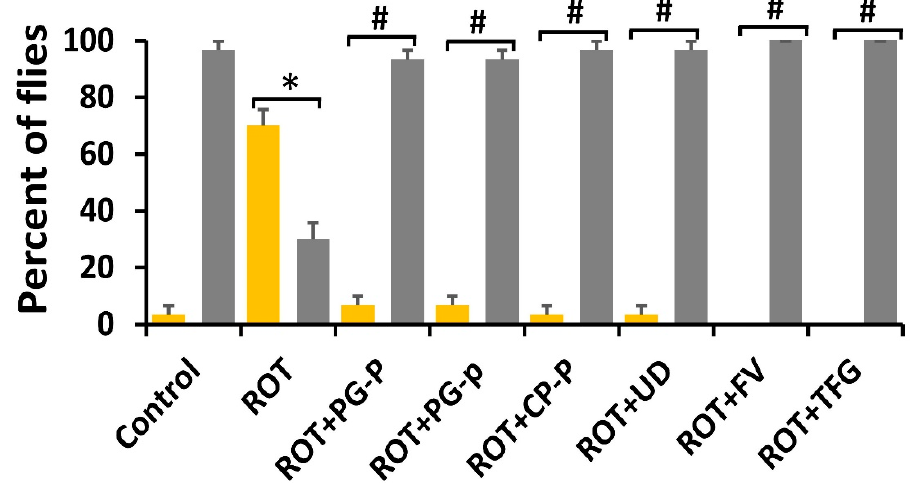
Figure 4. Drosophila melanogaster (Oregon R+) memory after a 16-h interval in the presence of the conditions. Fenugreek, FV; nettle leaves, UD; fennel, FV; pomegranate peel, PG-P; papaya peel, CP-P; rotenone, ROT; TFG, Trigonella foenum-graecum . Each observation was performed three times and is expressed as the mean ± SEM. Results were significant at p < 0.05. Significance was * p < 0.05 compared to control; # p < 0.05 compared to rotenone (light vs. light and dark vs. dark).